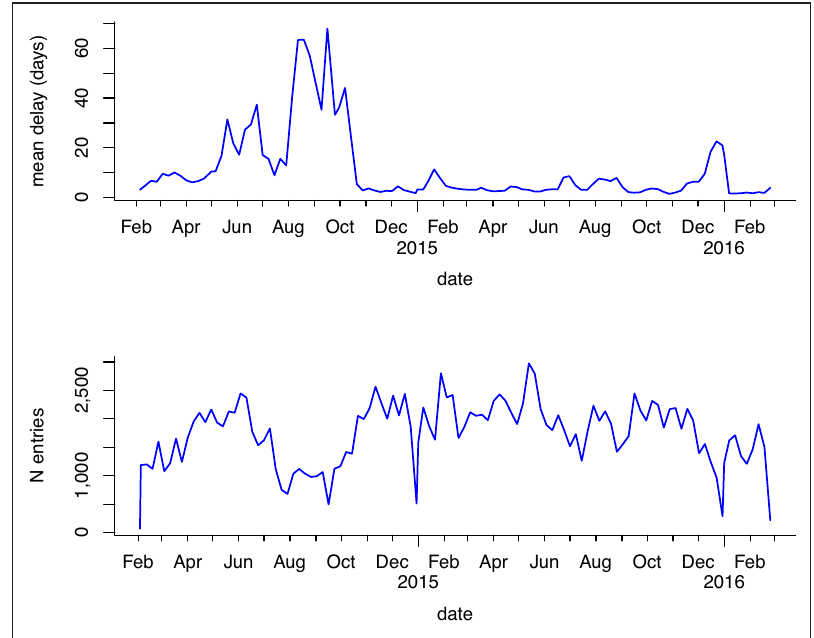
Figure 8: Mean delay (upper chart) and total entries per week (bottom chart) over